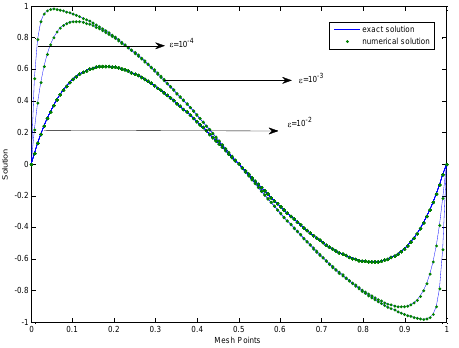
Fig 2. Graphical representation of solution in Example 2